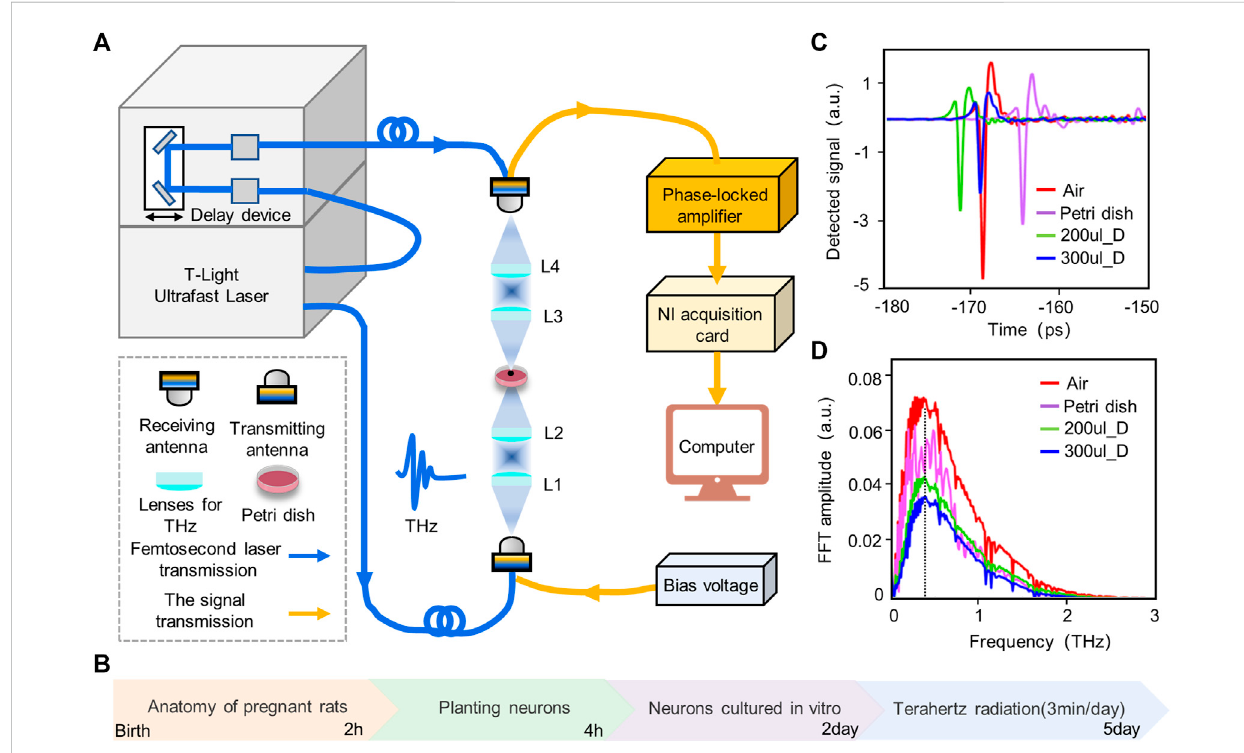
FIGURE 4 Experimental platform, protocol and terahertz wave attenuation test. (A) Experimental platform for wide-band terahertz radiation of cortical neurons.Weradiatedneuronsfromthebottomofapetridishandmeasuredtheamplitudeandfrequencyoftheterahertzwavespassingthroughthedish in real time. (B) Experimental protocol for terahertz radiating neurons. The experiment lasted for 5 days, with neurons being planted and cultured for the fi rst 2 days, followed by the accumulation of radiated neurons for 3 consecutive days. (C) Time domain diagram of terahertz after penetrating